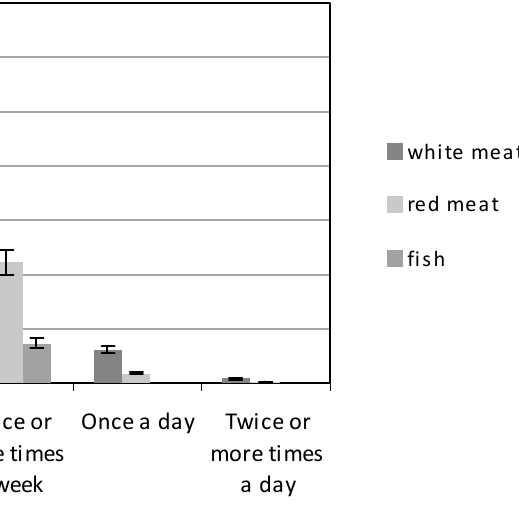
Figure 7. The consumption of fried dishes and processed meat products by participants.